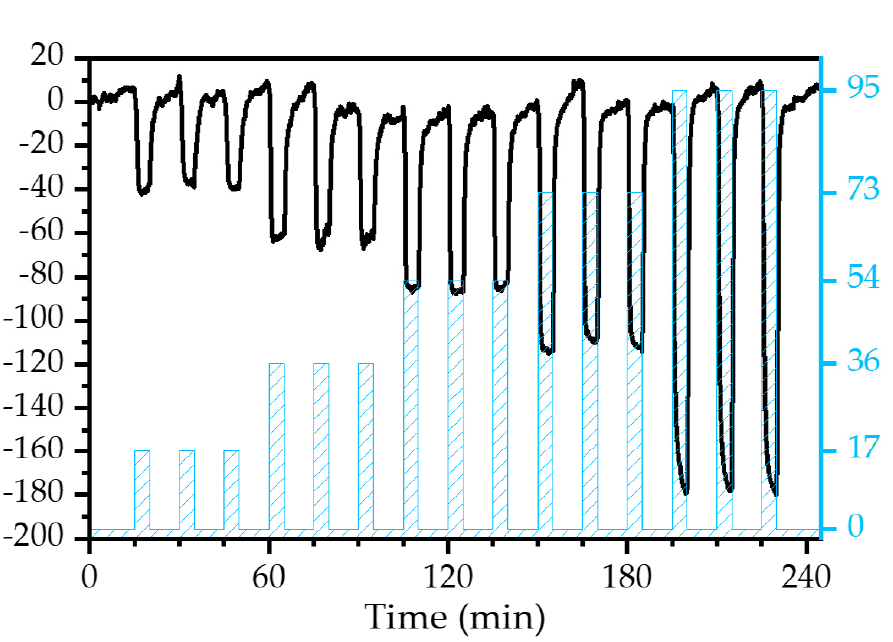
Figure 8. Real-time frequency shift of the device exposed to different RH